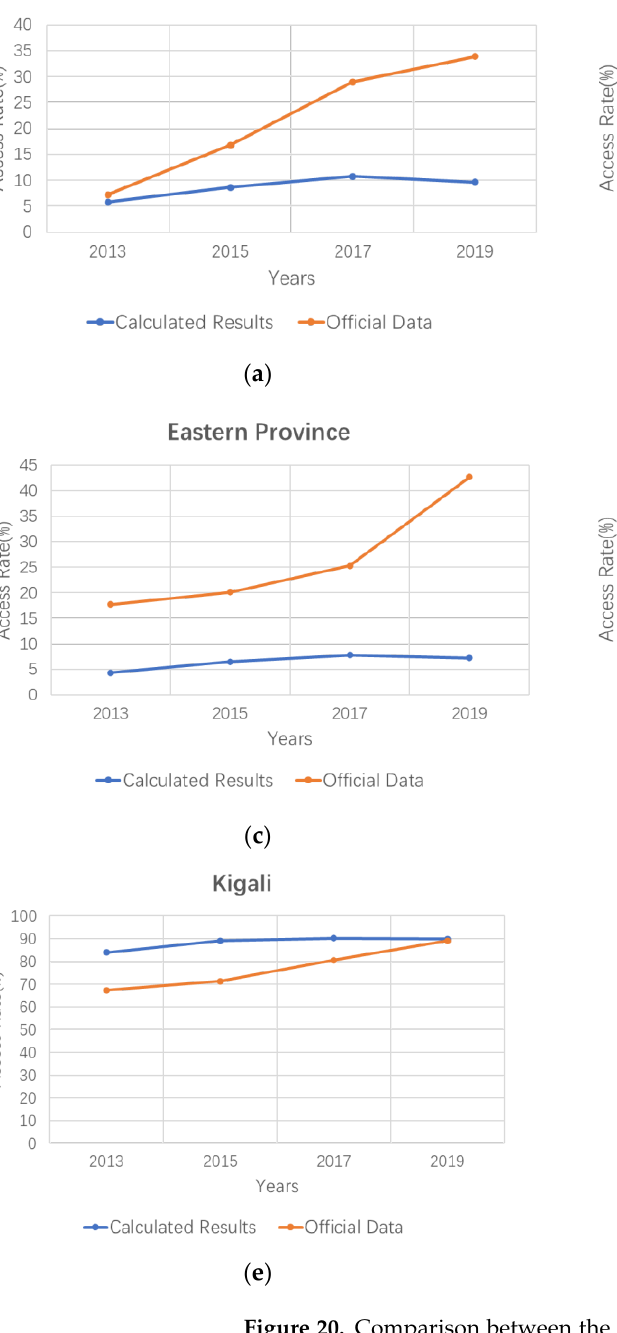
Figure 20. Comparison between the calculated grid access rates and the official electricity access rate data in 2013, 2015, 2017, and 2019 in: ( a ) Northern Province; ( b ) Southern Province; ( c ) Eastern Province; ( d ) Western Province; ( e ) Kigali.